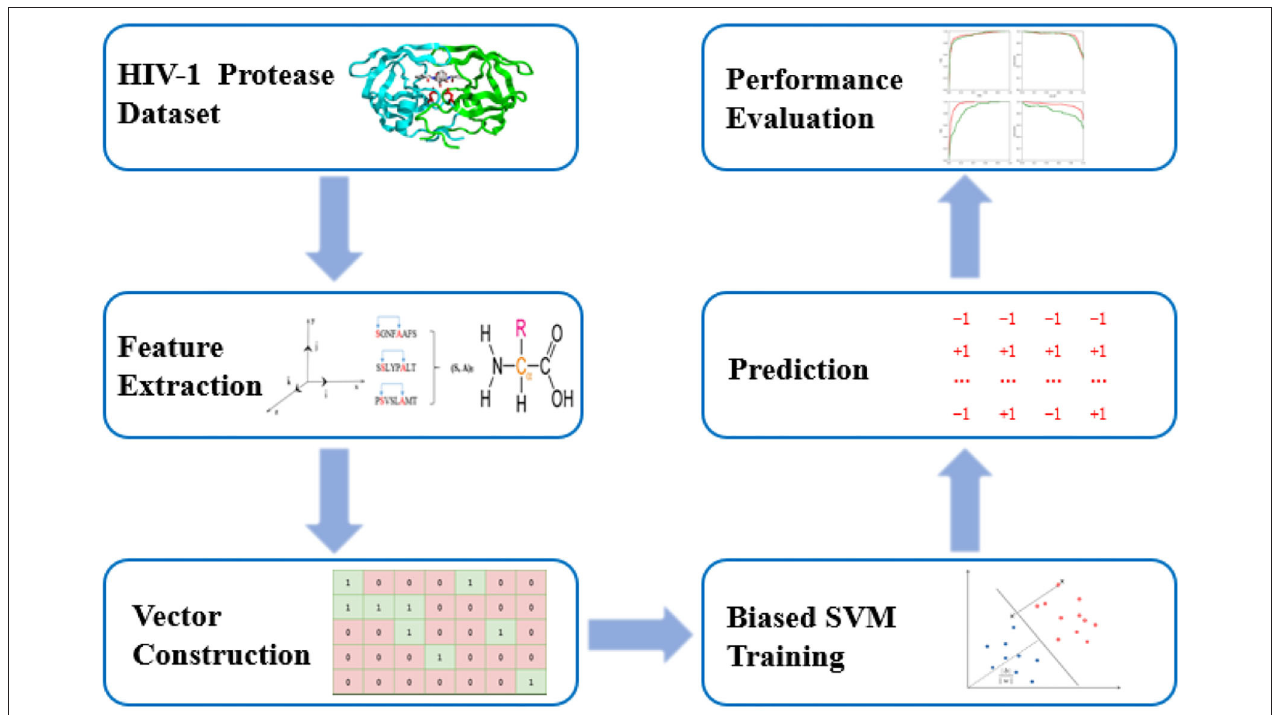
FIGURE 1 | The workflow of